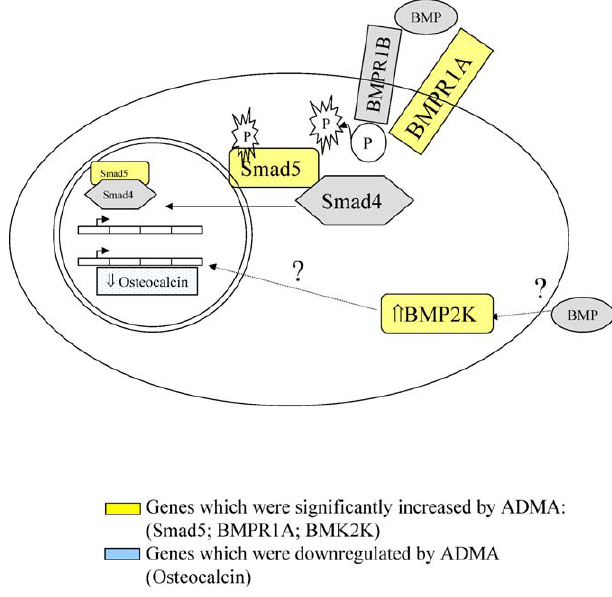
Figure 7. Involvement of ADMA-Affected Genes in the BMP Signalling Pathway Squares in yellow show genes that increased significantly on the GeneChip, whilst squares in blue show genes decreased by ADMA compared to untreated HCAEC, and ‘‘ ? ’’ represents an unknown mechanism of action. DOI: